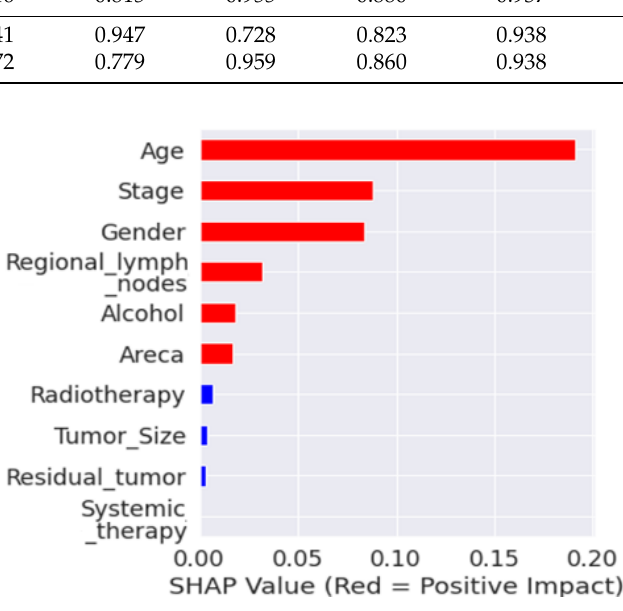
Figure 4. SHAP value for each characteristic (red: positive impact; blue: negative impact).